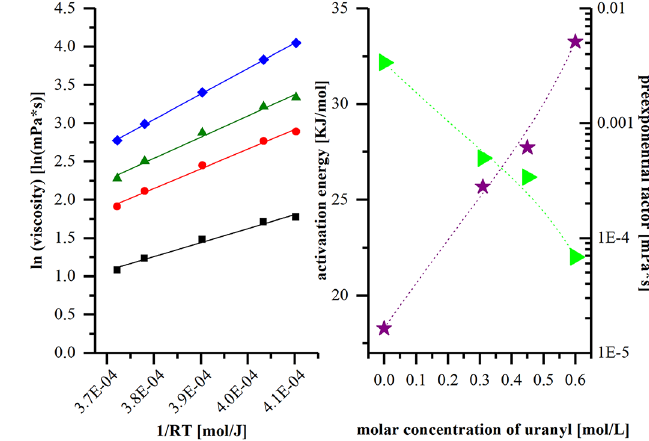
Fig. 7. Left: linear fi ts using equation (55) for 1.5M DEHiBA diluted in Isane IP 175 charged with ■ 0 M 0.31 M 0.45M 0.6 M Uranyl. Right: resulting fi t parameter from Arrhenius fi ts; preexponential factor, activation